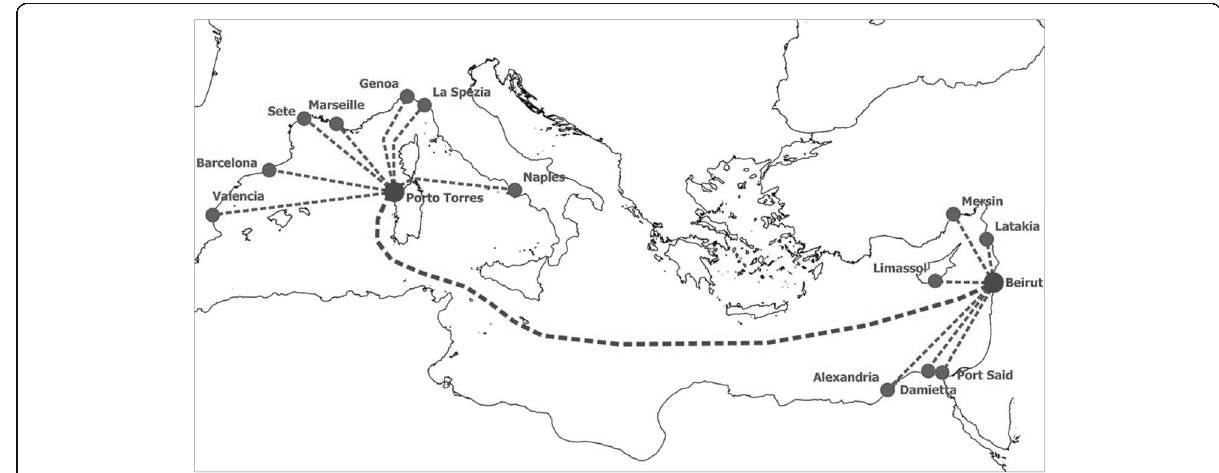
Fig. 2 Topological structure of the project network analyzed